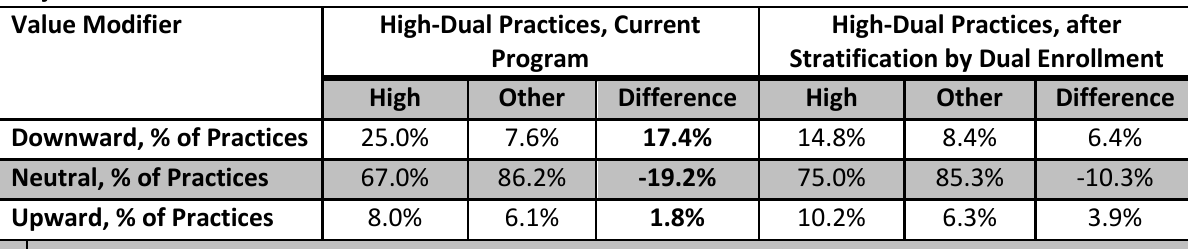
Table 10.21a. Impact of Stratification by Proportion Dually Enrolled, on Upward and Downward